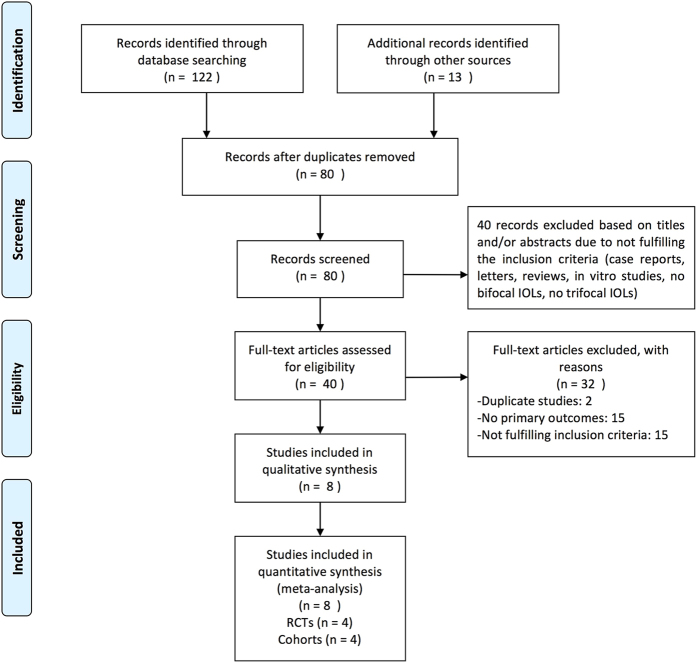
Flow chart showing selection of articles.IOL = intraocular lens; RCTs = randomized controlled trials.